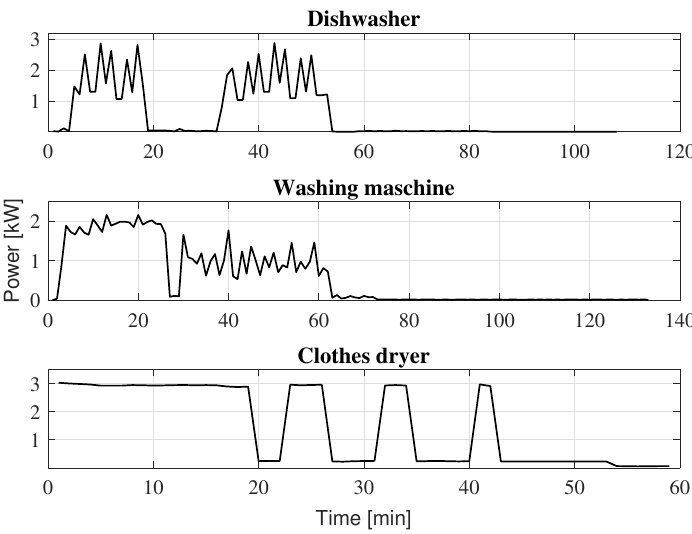
Figure 10. Applied profiles of integrated white goods with data extracted from